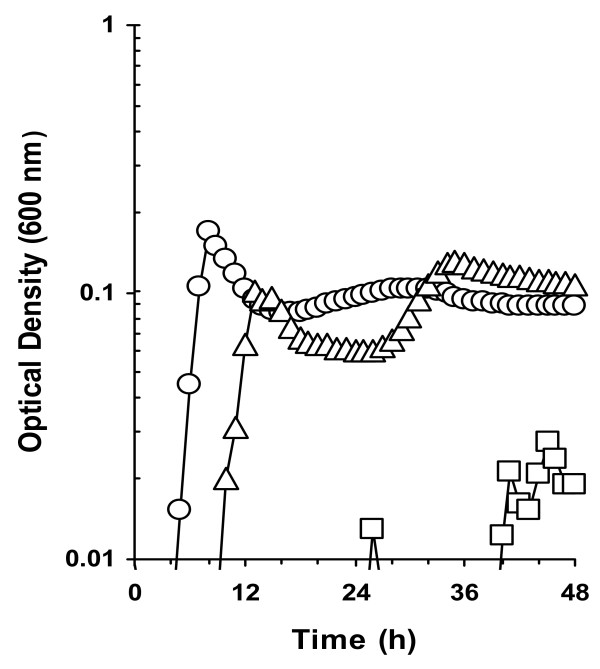
Effect of bile salts on the growth of E. coli O157:H7 43895 (parent) and hns mutant (FRIK47001P). Growth of the parent strain (○), hns mutant (□), and hns mutant complemented containing pSC0061 (Δ) in LB containing 5% bile salts number three at 37°C. Data points are the average values from three trials.